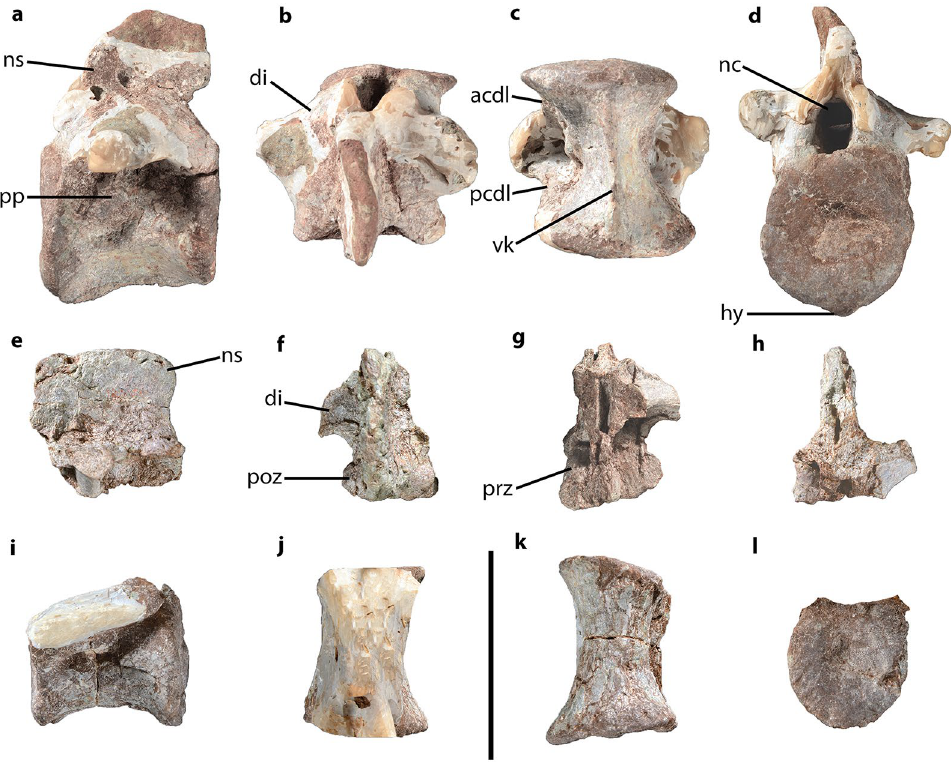
D9?) centrum. Abbreviations: acdl, anterior centrodiapophyseal lamina; di, diapophysis; hy, hypapophysis; nc, neural canal; ns, neural spine; pcdl, posterocentrodiapophyseal lamina; poz, postzygapophysis; pp, parapophysis; prz, prezygapophysis; vk, ventral keel. Scale bar = 10